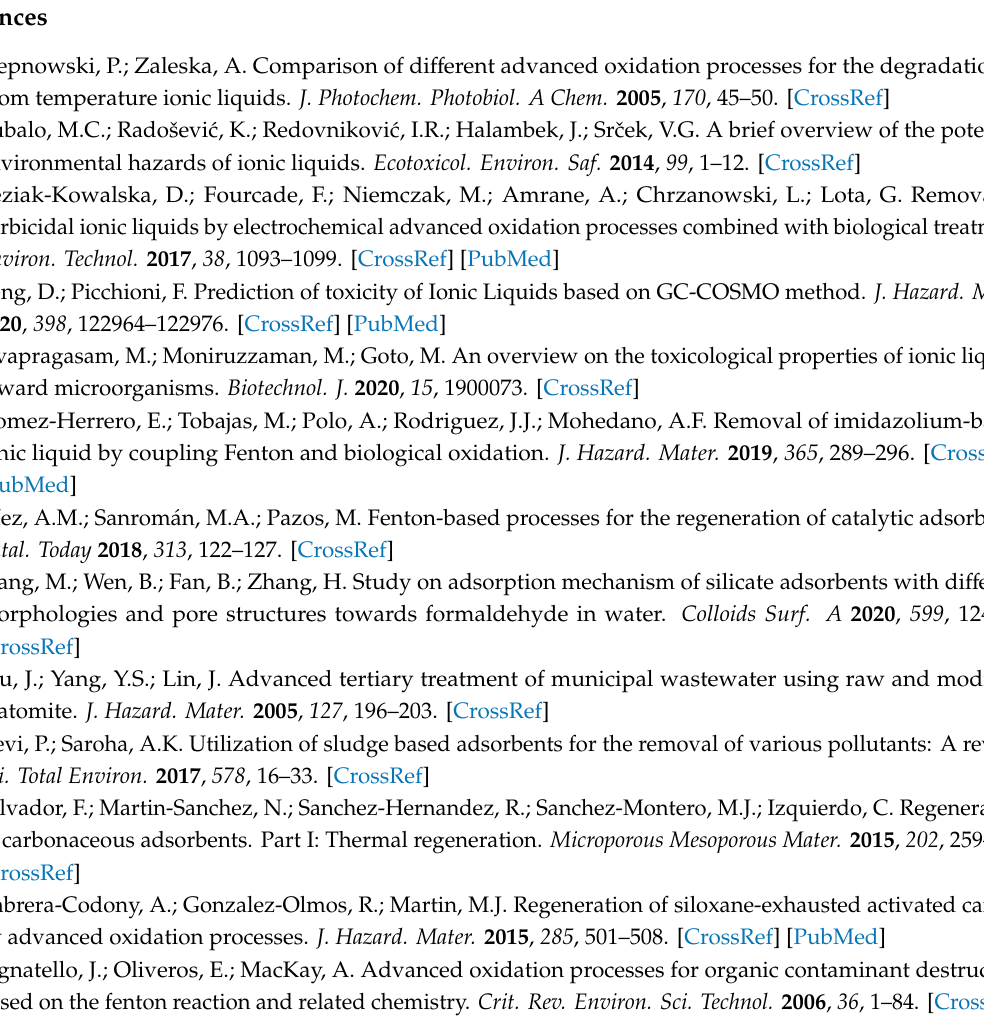
Figure S1. N 2 adsorption-desorption isotherms of sepiolite and S-Fe; Figure S2. Wide scan XPS spectra for ( a ) sepiolite and ( b ) S-Fe; Table S3. Comparison of the elemental composition between sepiolite and S-Fe; Figure S4. [bpy] Cl uptake profile in the five sections of the S-Fe adsorption column; Figure S5. Wide scan XPS spectra for ( A ) S-Fe, ( B ) exhausted S-Fe, ( C ) exhausted S-Fe after first EF treatment ( D ) exhausted S-Fe after second EF treatment, and ( E ) exhausted S-Fe after third EF treatment; Table S6. Elemental composition of the adsorbent during three adsorption-regeneration